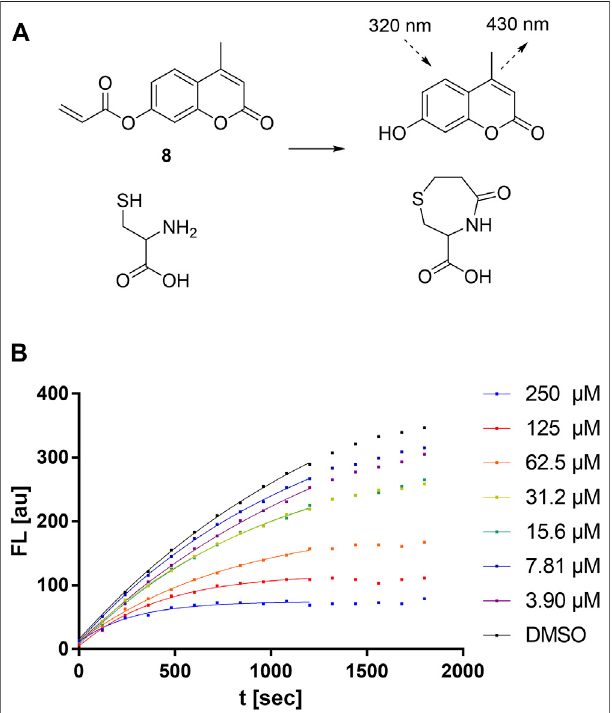
FIGURE 7 | Cysteine reactivity assay. (A) Mechanism of the fl uorescent probe 8 reacting with cysteine. (B) Cysteine reactivity assay with variable concentrations of compound 5a showing hyperbolic substrate conversion plots. The fl uorescence was recorded for 30 min every 30 s. For clarity, only every fourth data point is